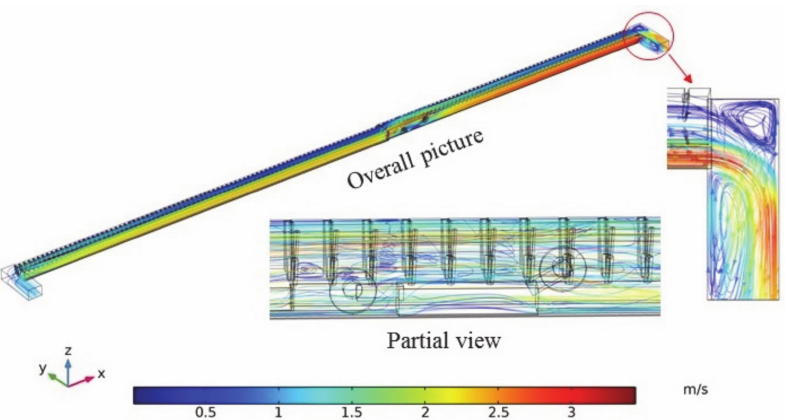
Figure 3. Streamline diagram of the wind flow field.